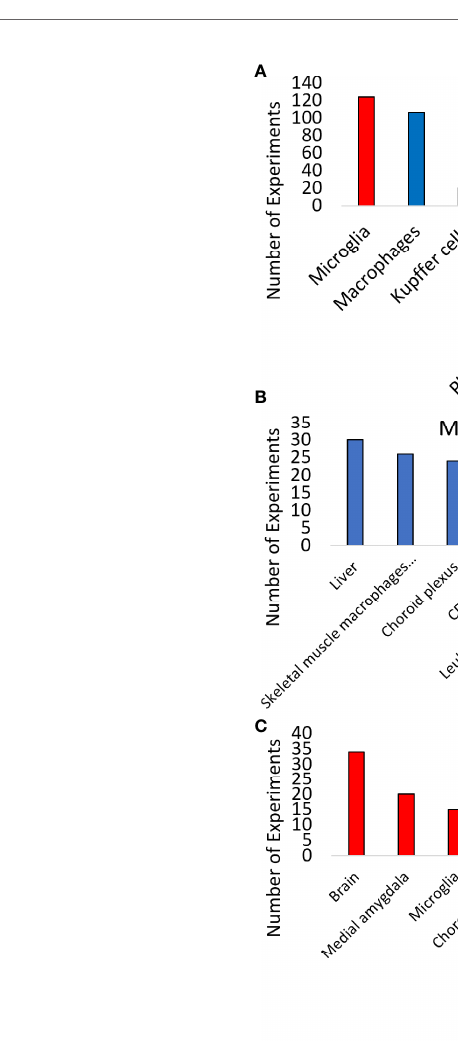
FIGURE 4 | Expression of CCR5 in 1,063 mouse single-cell datasets. (A) PanglaoDB analysis of experiments that CCR5 was detected in various cells based on single-cell analysis. (B, C) The number of times sample types showed CCR5 expression for macrophages/monocytes (B) or microglia (C)